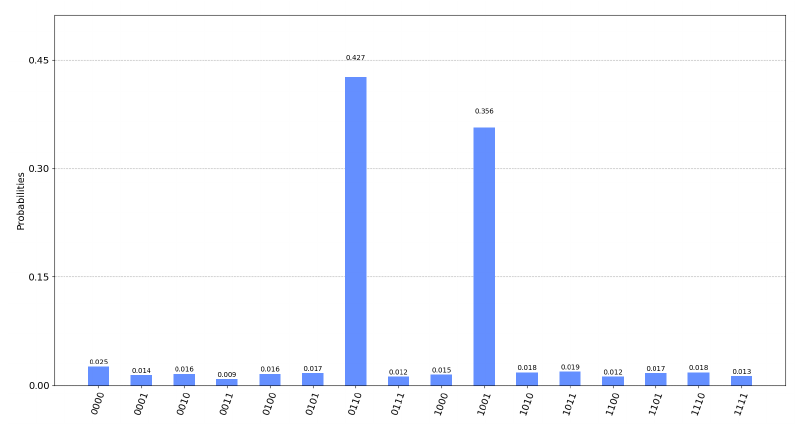
Figure 23. Results of the simulation for the map in Figure 22.